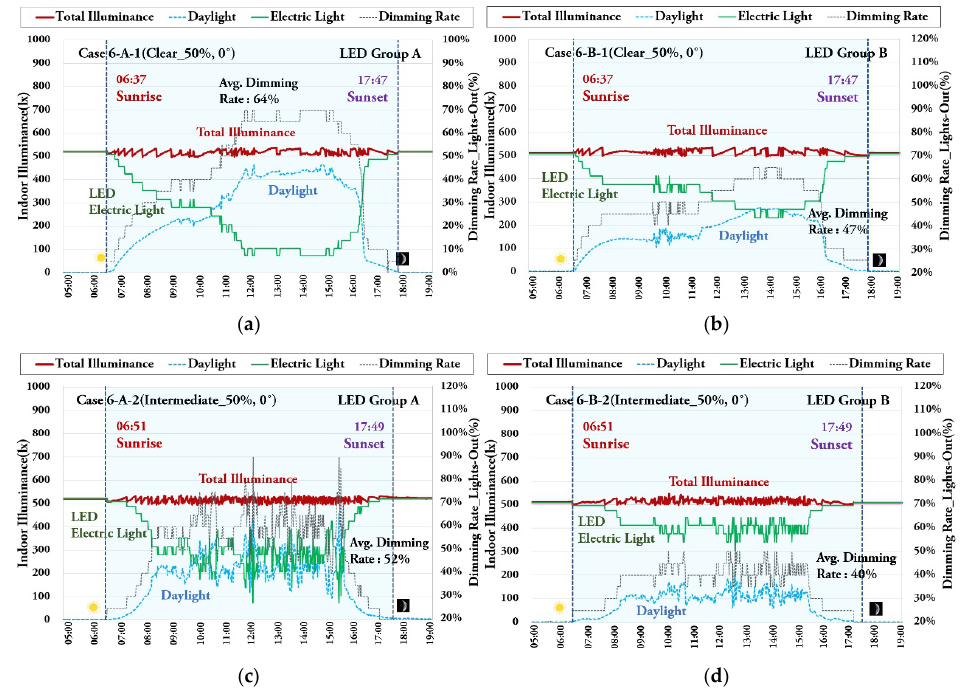
Figure 18. Illuminance and dimming rate under dimming control integrated with manual blind (Blind VP 50%, Slat angle 0 ◦ ). (clear sky_10.13 and intermediate sky_10.22). ( a ) Case 6-A-1, ( b ) Case control. (Blind VP 50%, Slat angle 0°). (clear sky_10.13 and intermediate sky_10.22). ( a ) Case 6-A-1, 6-B-1, ( c ) Case 6-A-2, and ( d ) Case 6-B-2 in Table 6. Energies 2020 , 13 , 3238 ( b ) Case 6-B-1, ( c ) Case 6-A-2, and ( d ) Case 6-B-2 in Table 6.